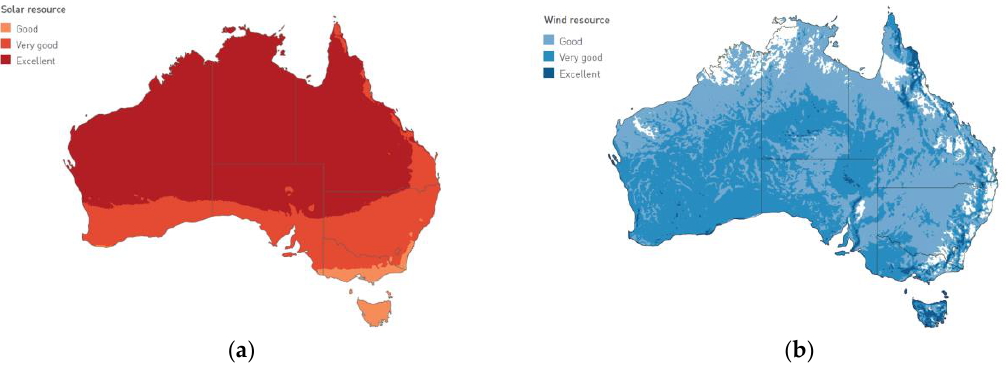
Figure 3. ( a ) Australian solar source map, ( b ) Australian wind source map. (Source: Australian Renewable Energy Agency; The Australian Government Bureau of Meteorology Average daily solar exposure dataset; the CSIRO DATA61 Mesoscale Wind Atlas Data dataset).